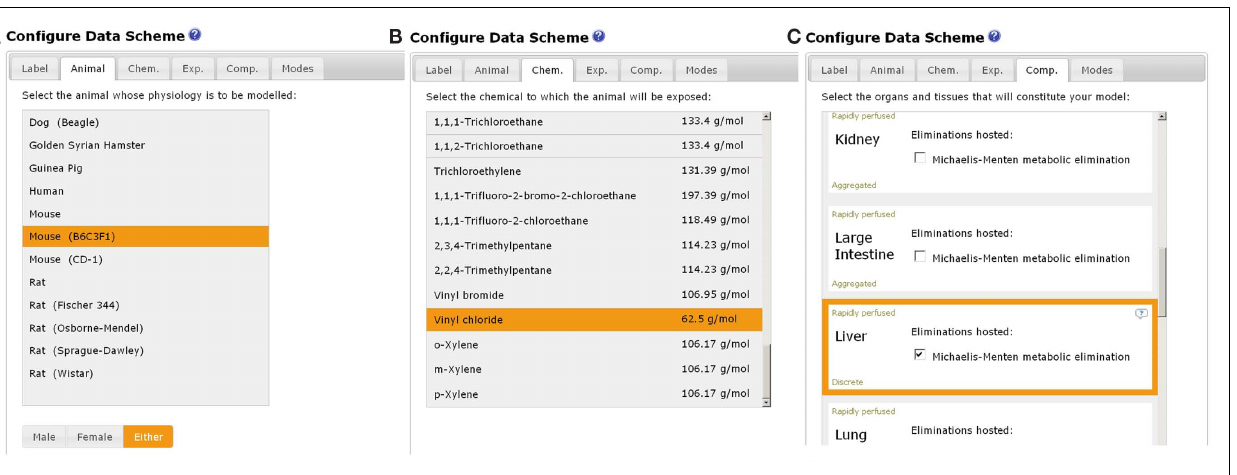
FIGURE 5 | Configuration pages: selection of, (A) animal, (B) chemical, and (C) compartments.